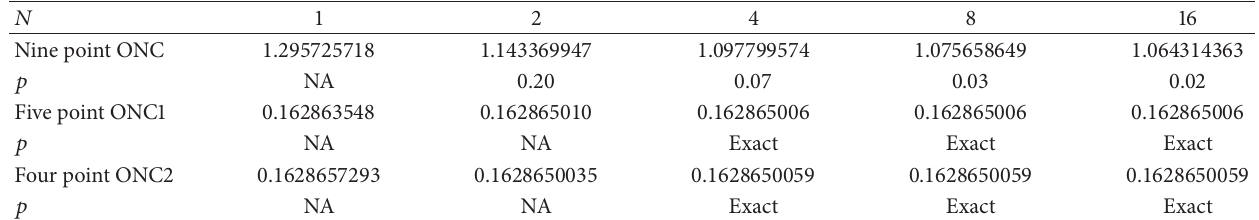
1 (𝑥 ln (1 + 𝑥)/(1 + 𝑥 2 ))𝑑𝑥 0